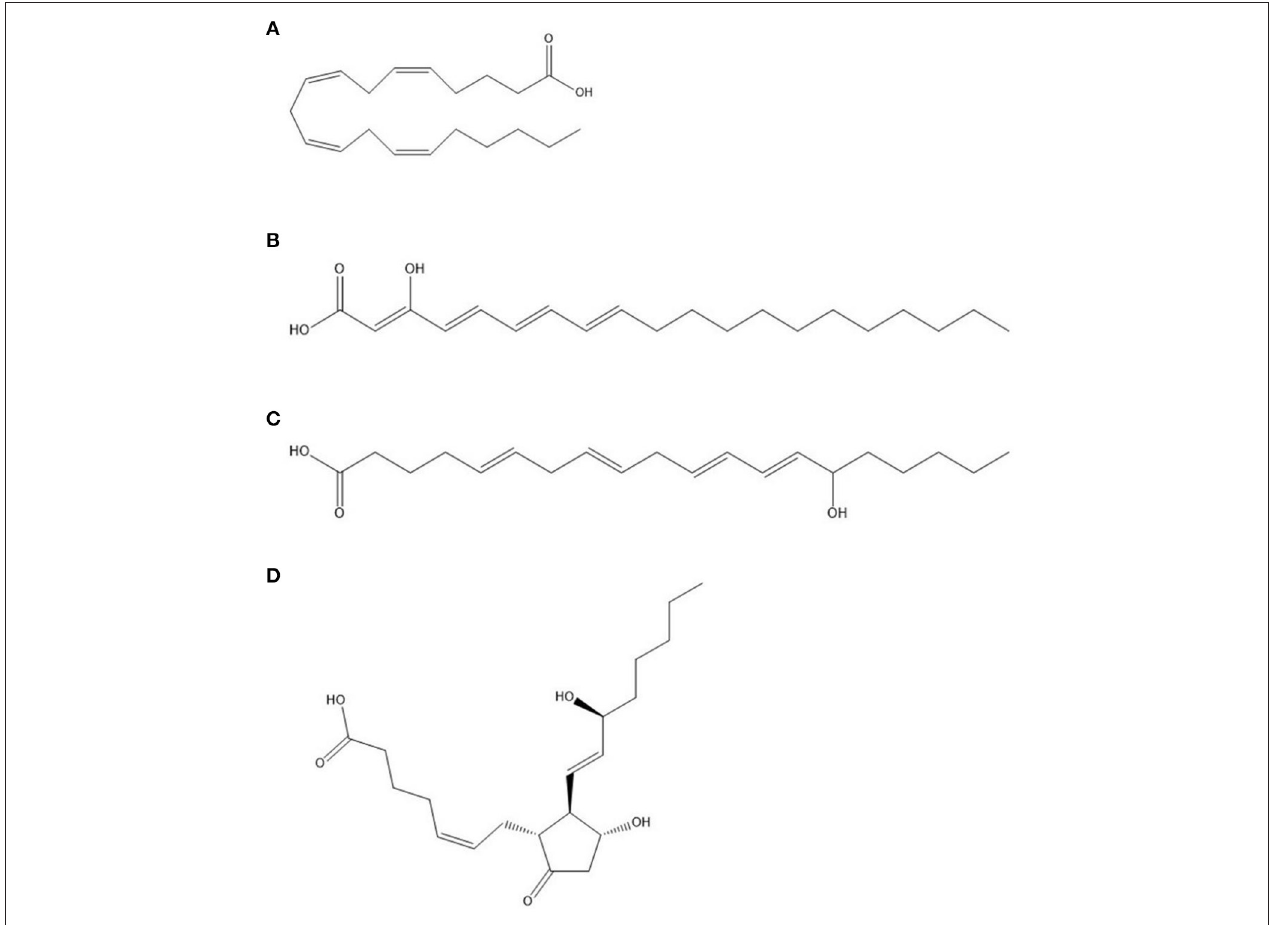
FIGURE 6 | Structures of (A) arachidonic acid (AA) at the top, followed by (B) 3-hydroxyeicosatetraenoic acid (3-HETE); (C) 15-HETE; (D) Prostaglandin E 2 at the